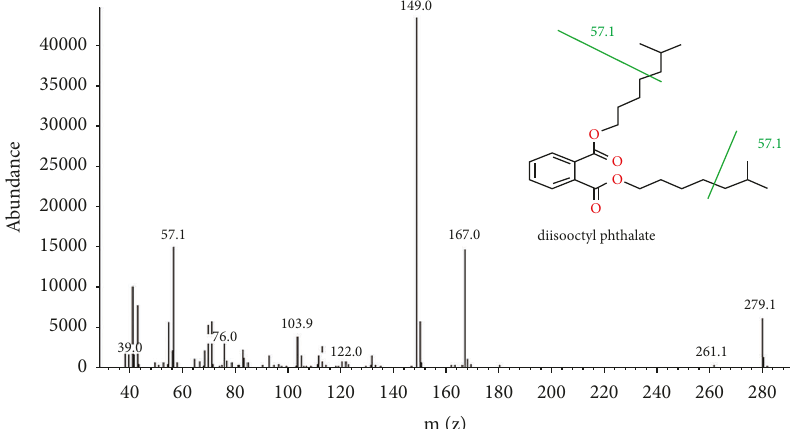
Figure 9: MS spectrum and the fragmentation pattern of diisooctyl